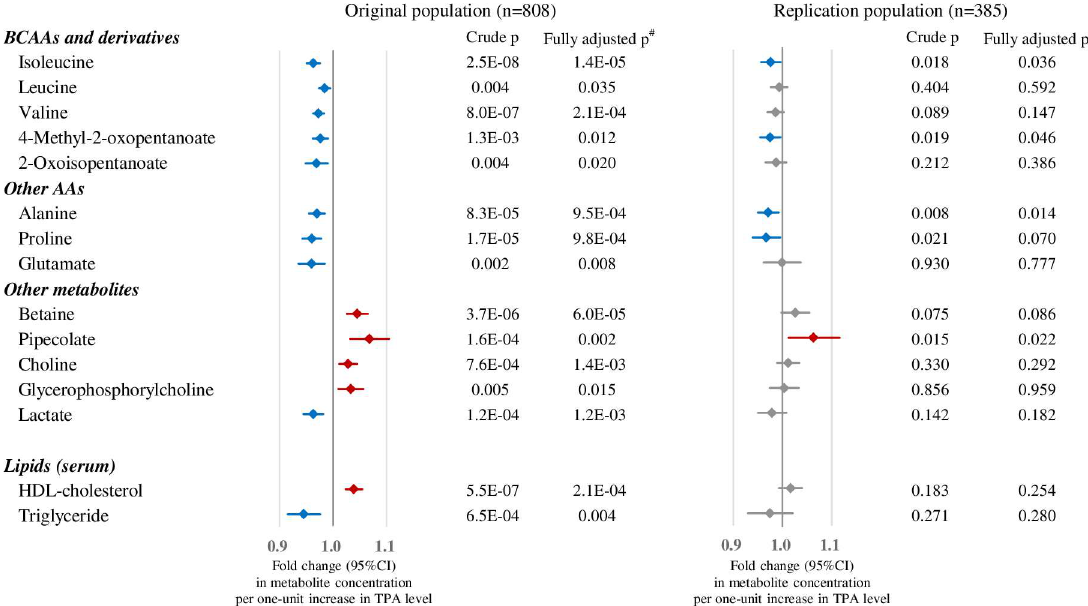
Fig 2. Associations between TPA and metabolite measurements. Associations between metabolites and TPA level (Q1, Q2, Q3, Q4) in the original(left) and replication(right) populations. Linear regressionbetween each metabolite and TPA was performed. Raw p-values for unadjustedand adjusted models are shown. Fold change(with 95% CI) per one-unit increase in TPA level were calculatedusing the beta of the linear regression analysis of the unadjusted model. The blue bars mean lower concentrations and the red bars mean higher concentrations in highly active groups. Metabolites associated with TPA levels are shown in this figure (FDR p < 0.05 for unadjustedmodel in the originalpopulation).Replicationanalysiswas performed only for these metabolites. AAs, amino acids; CI, confidence interval. # Adjusted for age, BMI, smoking (never/former/current), current alcohol drinker (yes/no), and energy intake (high/low).